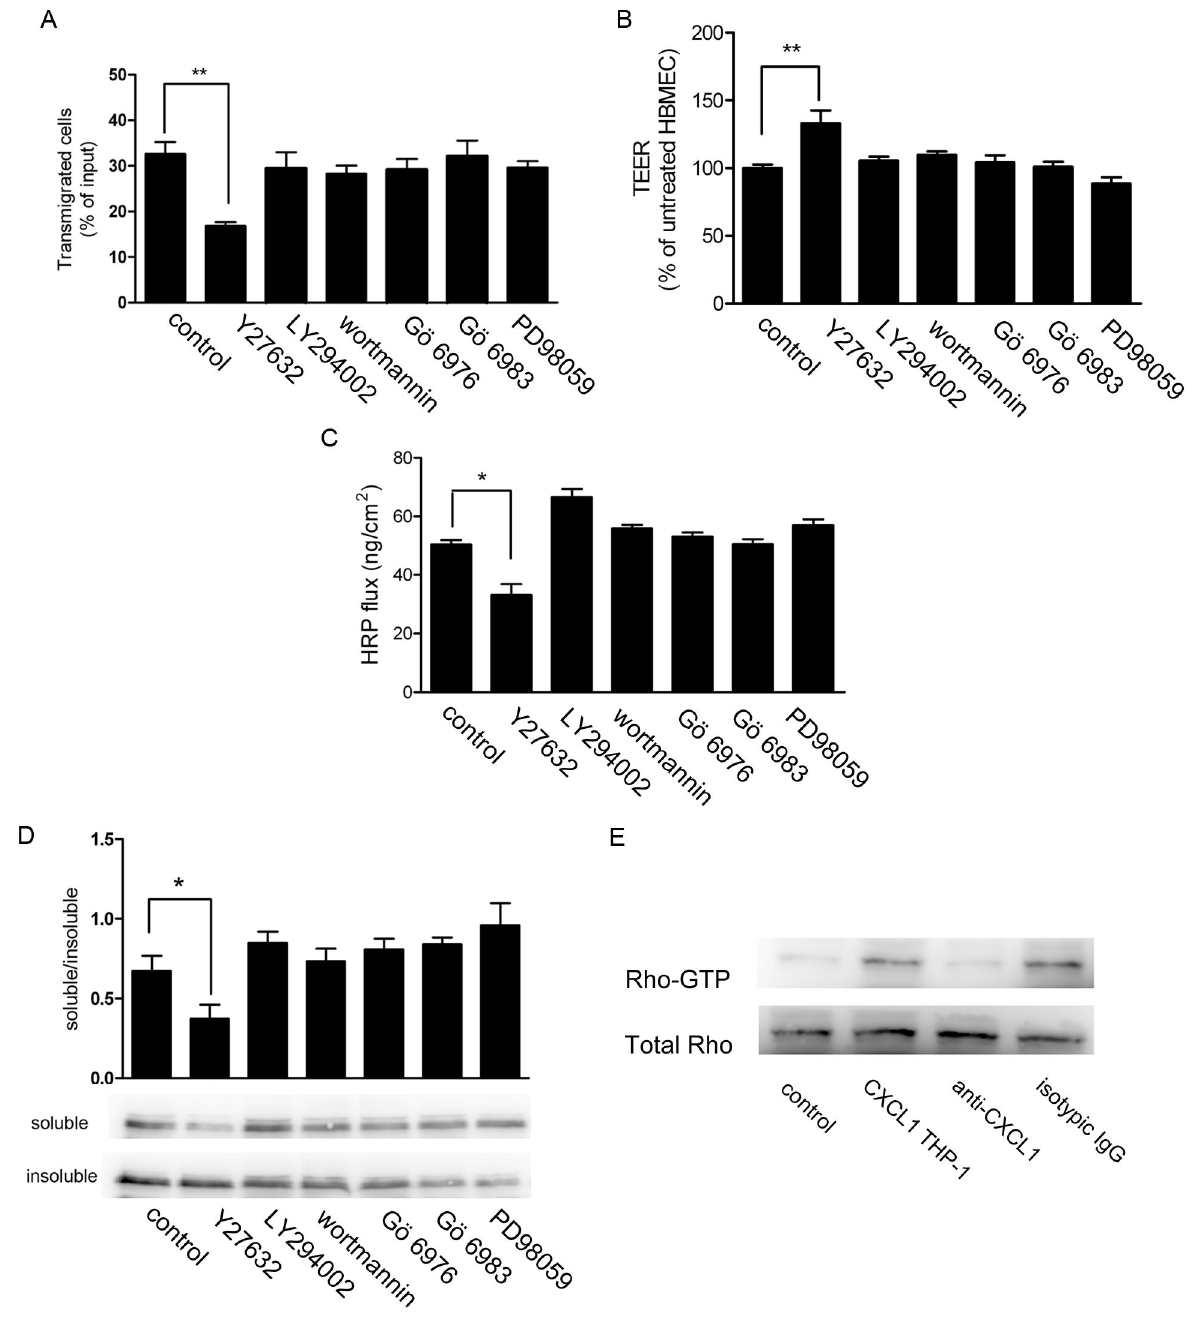
Figure 6. ROCK inhibitor Y27632 could block CXCL1-overexpressing THP-1 cells transendothelial migration. HBMEC were pretreated with specific inhibitors as described in Material and Methods and then co-cultured with CXCL1-overexpressing THP-1 cells for 24h. Transmigrated CXCL1-overexpressing THP-1 cells (A), TEER (B) and HRP flux (C) were measured, respectively. The different detergent solubility of endothelial occludin were analyzed by Western blot (D). Data were means ± S.D. of three independent experiments. * p < 0.05, ** p < 0.01. (E) Confluent HBMEC was co-cultured with CXCL1-overexpressing THP-1 cells for 24h. The Rho activity in HBMEC was analyzed.